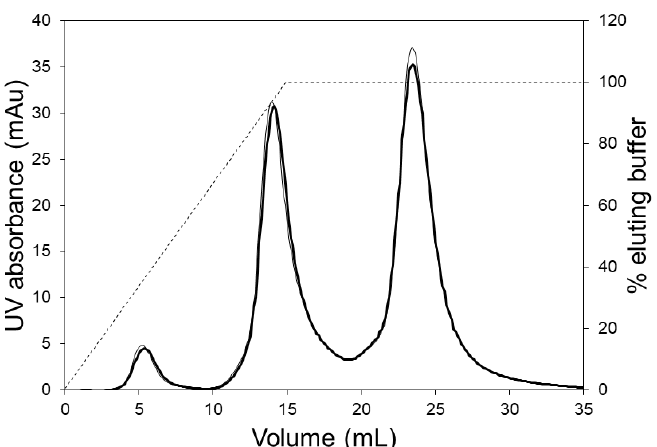
Figure 4. Model protein separation using the LFMC device at high flow rates (membrane: Sartorius S cation exchange; membrane bed volume: 4.7 mL; feed: 0.2 mg/mL ovalbumin, 1.0 mg/mL conalbumin, 0.5 mg/mL lysozyme; sample volume: 500 µL; binding buffer: 20 mM sodium citrate pH 5.5; eluting buffer: binding buffer + 0.5 M NaCl; linear gradient volume: 15 mL; thin line: 25 mL/min flow rate; thick line: 30 mL/min flow rate; solid line: UV absorbance; dashed line: elution gradient).